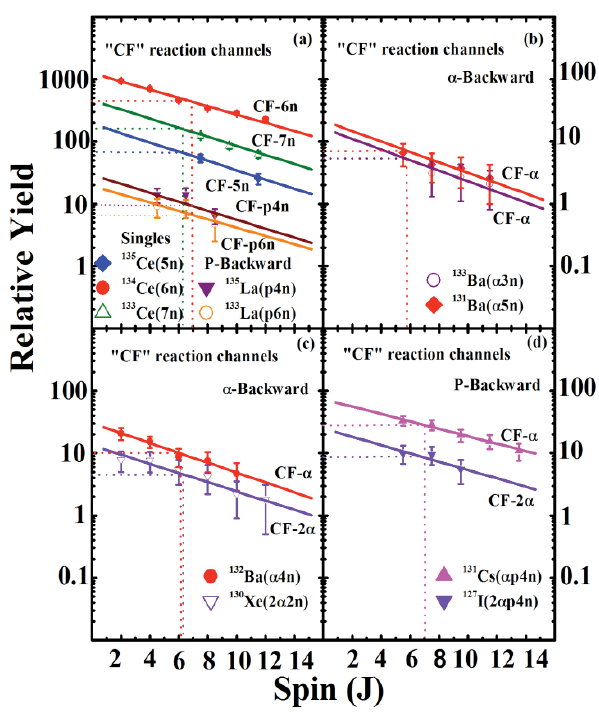
Figure 1. (Colour online) (a)-(d) experimentally measured spin distribution of evaporation residues produced in CF for the system 16 O + 124 Sn at 6.3 MeV/nucleon. The straight lines are the least-squares fits. above ICF evaporation residues, observed in coincidence with fast α-particle(s) emitted in forward cone, are shown in Fig. 2(a)-(c). The spin distribution curves in this Figs.2